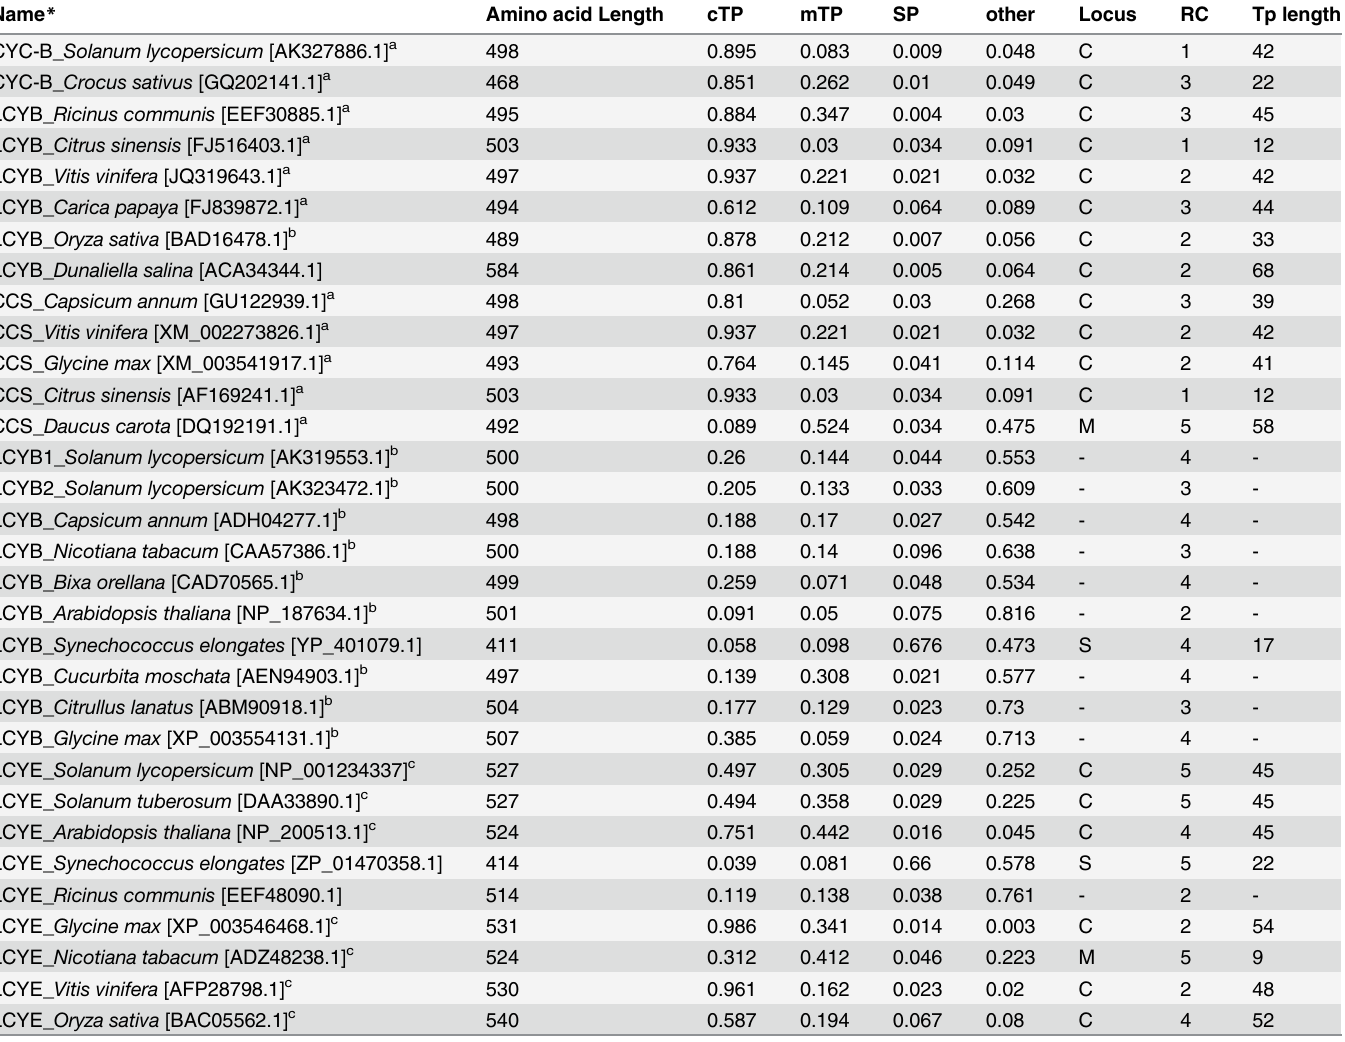
Table 2. Subcellular localization scores of CYC-B homologues predicted using ‘ TargetP 1 . 1 ’